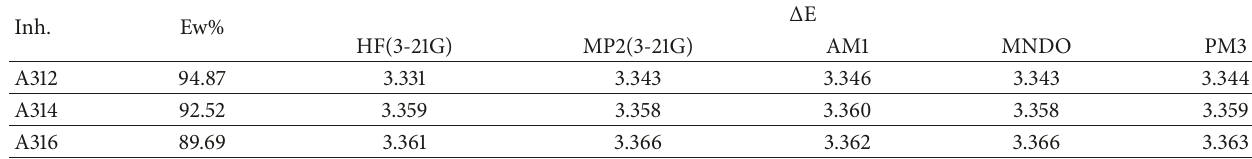
Table 7: The relation between the energy gap Δ E and the experimental inhibition efficiency (Ew %) of the synthesized corrosion inhibitors.